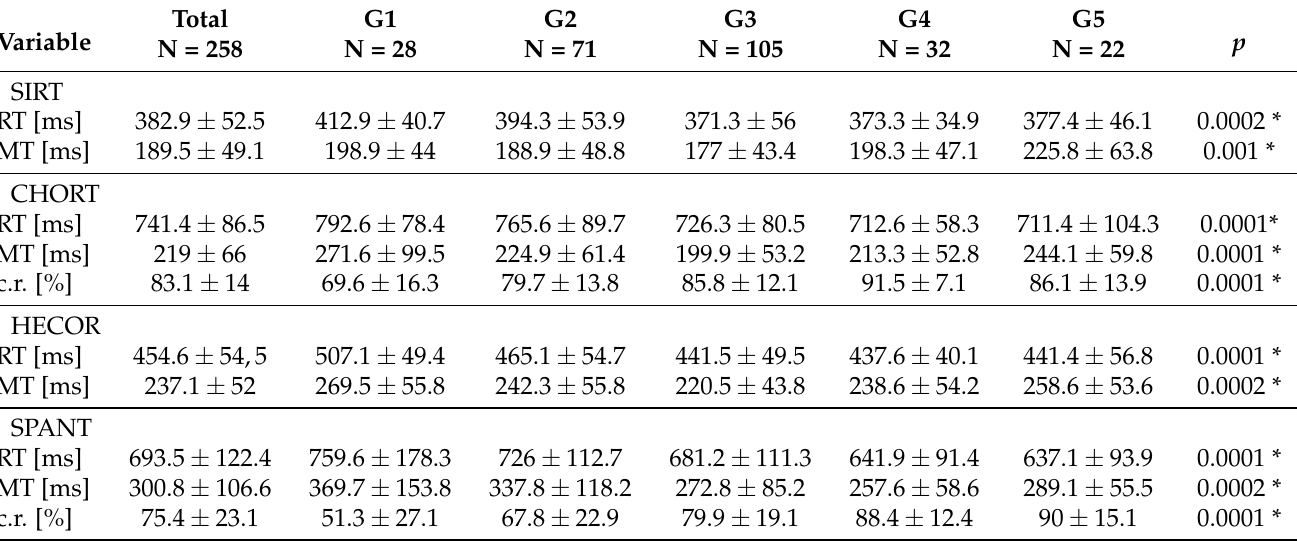
Table 2. Numeral characteristics of psychomotor abilities of football players.